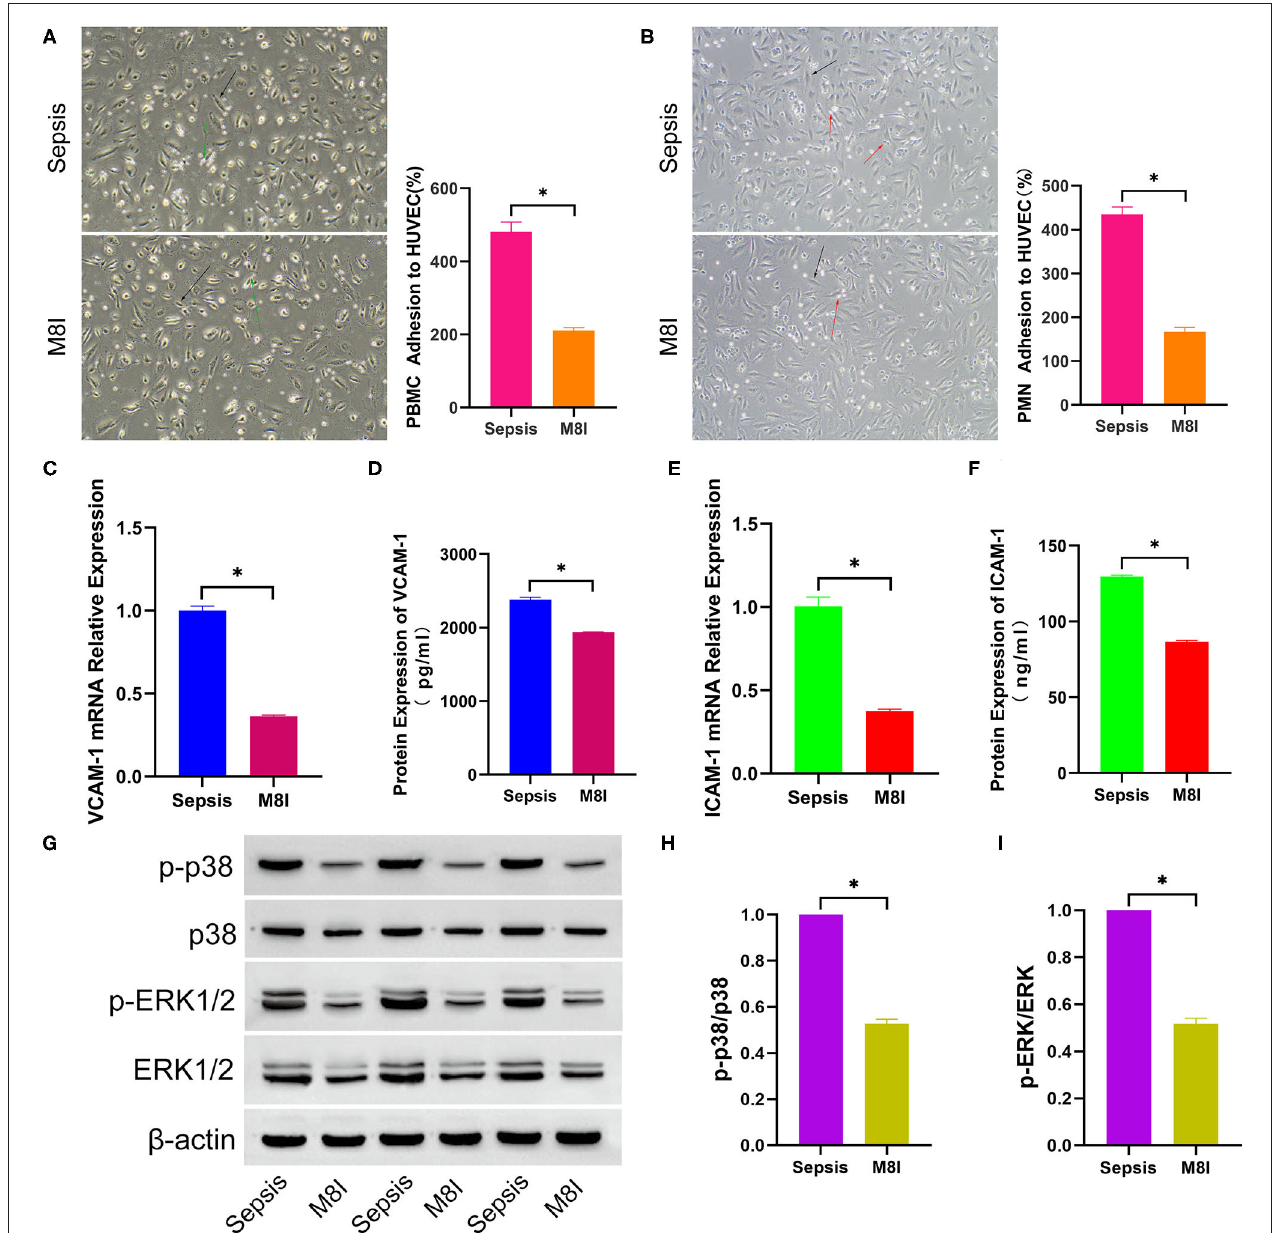
FIGURE 5 | M8I Inhibits the effect of sepsis serum on promoting leukocytes adhesion to HUVEC. After incubated with differently treated HUVEC for 2h, PBMC (A) and PMN (B) adhesion to HUVEC were shown in the bright field picture and measured by calculating the difference of cell counts between incubated leukocyte and washed leukocyte. The black arrow indicates HUVEC, green arrow indicates PBMC, and red arrow indicates PMN. After HUVEC treated with sepsis serum and M8I (20 µ M) for 6h separately, the mRNA expression of VCAM-1 (C) and ICAM-1 (E) were measured by q-RTPCR, and the protein level of VCAM-1 (D) and ICAM-1 (F) in supernatant were detected by ELISA. (G) The protein expression of total p38, p-p38, total ERK1/2, and p-ERK1/2 between sepsis group and control group was tested by western blotting assay. The relative gray value is shown in histogram (H,I) . * p < 0.05 between control and sepsis group by using t